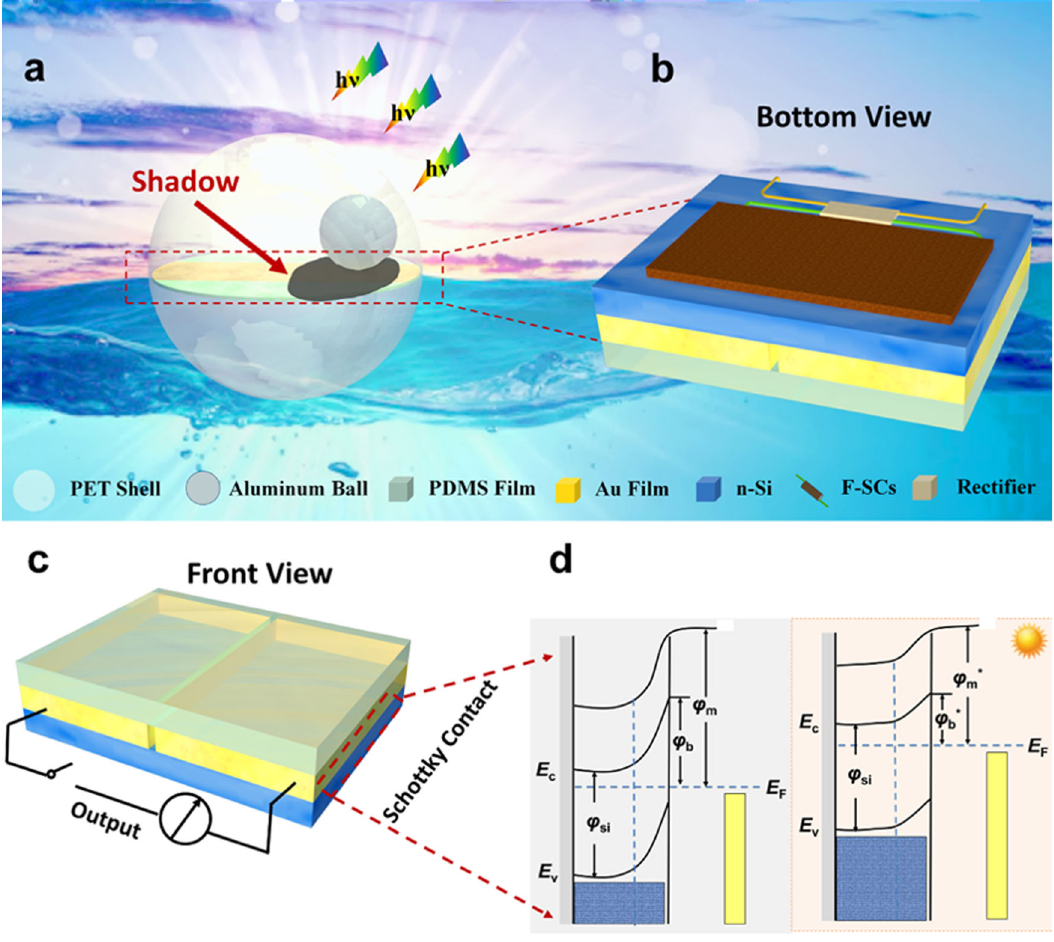
Fig. 1 Structure design of energy ball and energy band diagram of the shadow-effect. a Schematic of the energy ball (diameter is 8 cm, F-SCs is short for fi ber-supercapacitor) harvesting both solar energy and wave energy from ocean. Schematic illustration showing the con fi guration of the shadow-tribo- effect nanogenerator based self-charging power system: b bottom view and c front view. d Representative energy band diagram of Au/n-Si